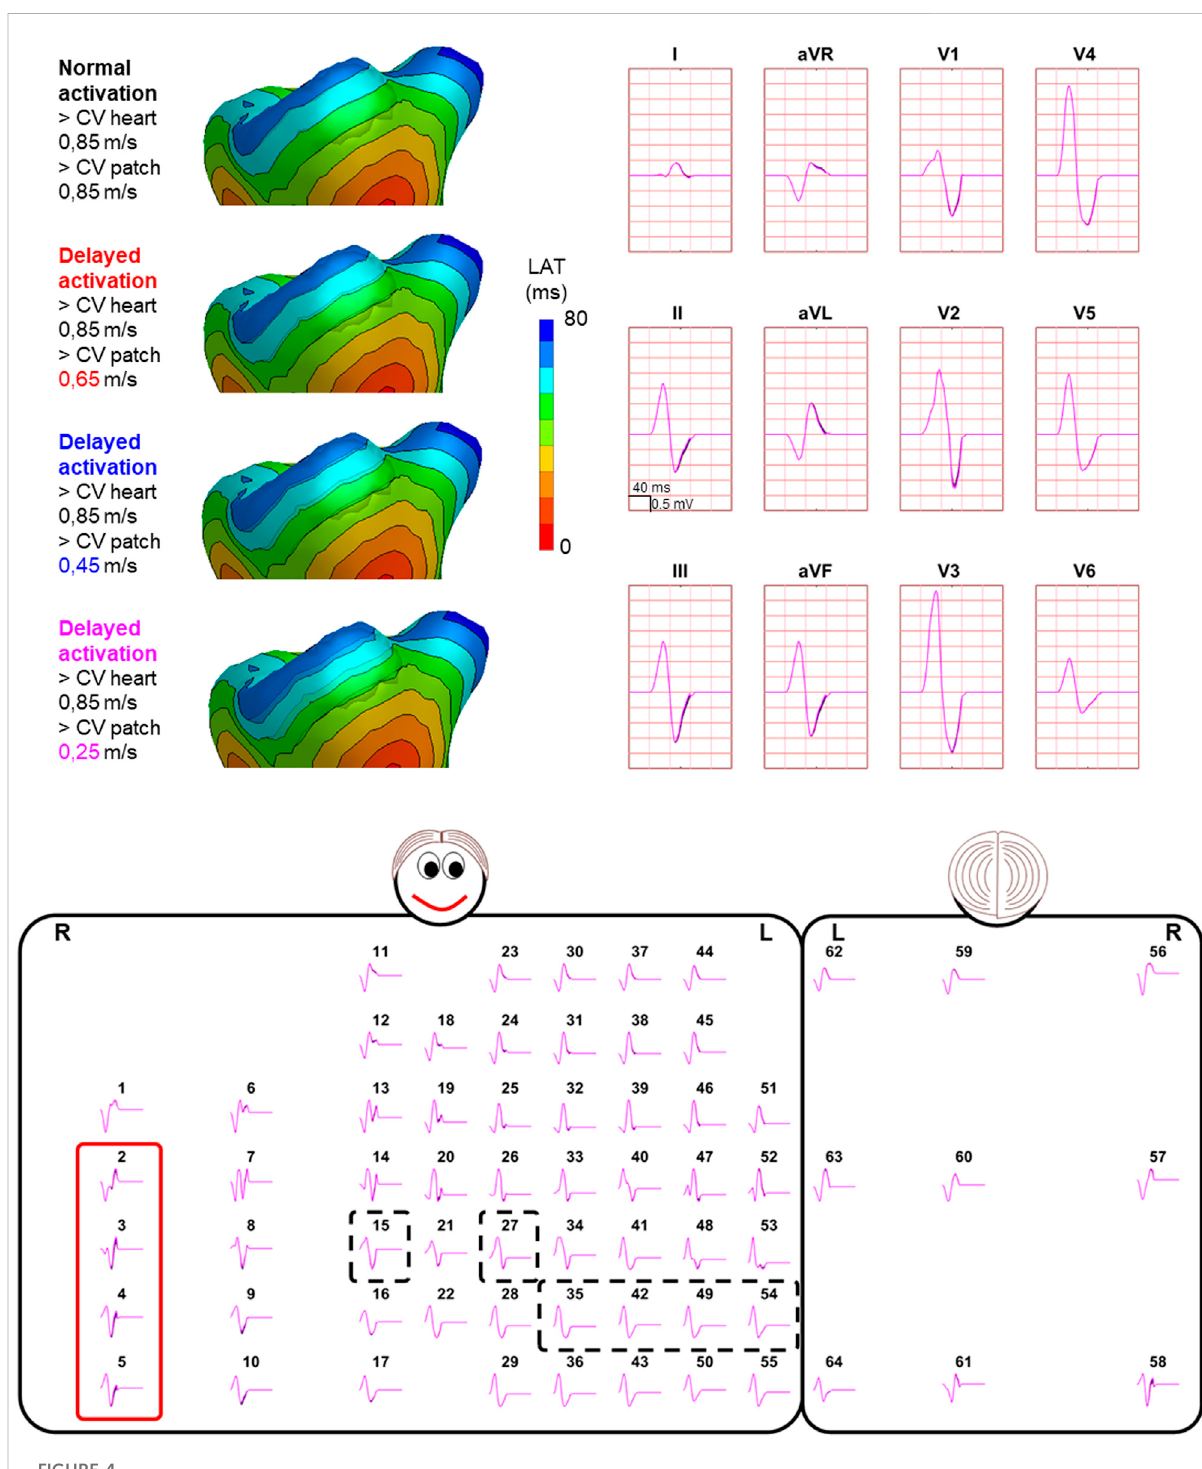
FIGURE 4 Effect of delayed patch activation on body surface potentials. Representative example of the effect of delayed patch activation reducing the propagationvelocitythroughthepatch.Activationsequencesofthepatchesandventriclesaredisplayedfromred(early)toblue(late)withisochrone steps of 10 ms. All simulated BSP are displayed in the simulated 12-lead ECG and the 64-lead BSP. The colors in the ECG correspond to the colors stated in the left column with the simulation characteristics. Within the 64-lead BSP, maximum changes in QRS complex were observed in the leads indicated with the red box. Electrode position of the 12-lead ECG was indicated by the black dashed boxes. One cube in the 12-lead ECG corresponds to 40 ms (width) and 0.5 mV (height) as also indicated in lead